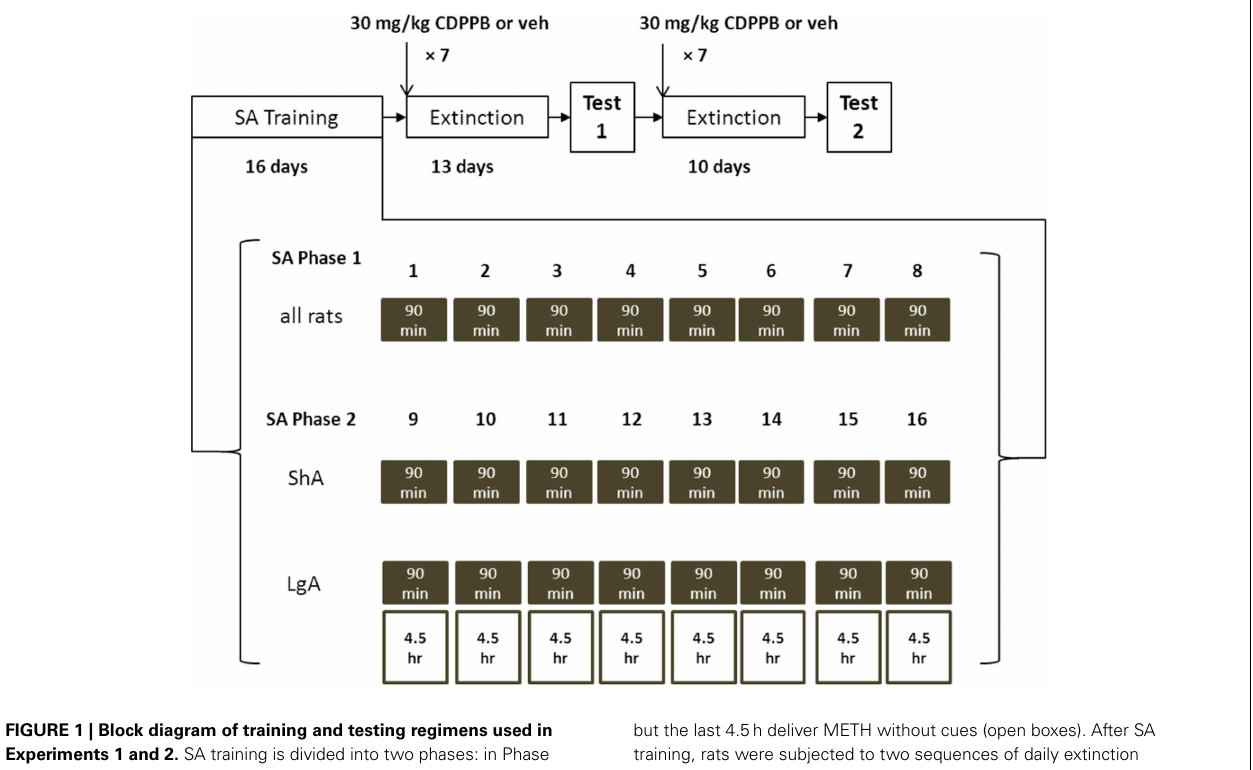
FIGURE 1 | Block diagram of training and testing regimens used in Experiments 1 and 2. SA training is divided into two phases: in Phase 1 all rats are trained to SA METH in the presence of lever-contingent sensory cues for 90min; in Phase 2 ShA rats continue to be trained with cues for 90min (shaded boxes), and LgA rats are trained in 6-h SA sessions, where the first 90min continue to deliver METH with cues